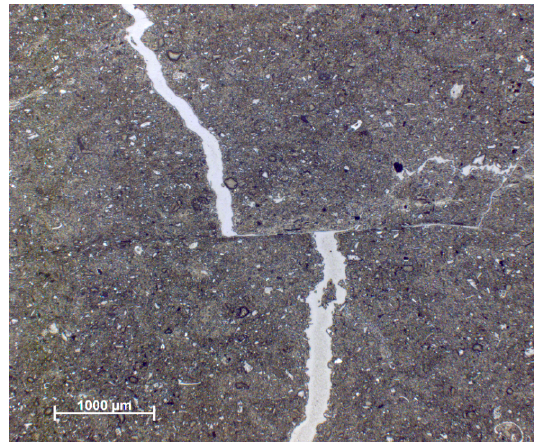
Figure 11. Reflected light image shows how a fracture has moved en-echelon along a thin, dense, horizontal seam in sample KM1 B5 (Plate C32 from Supplementary Materials Section S3).